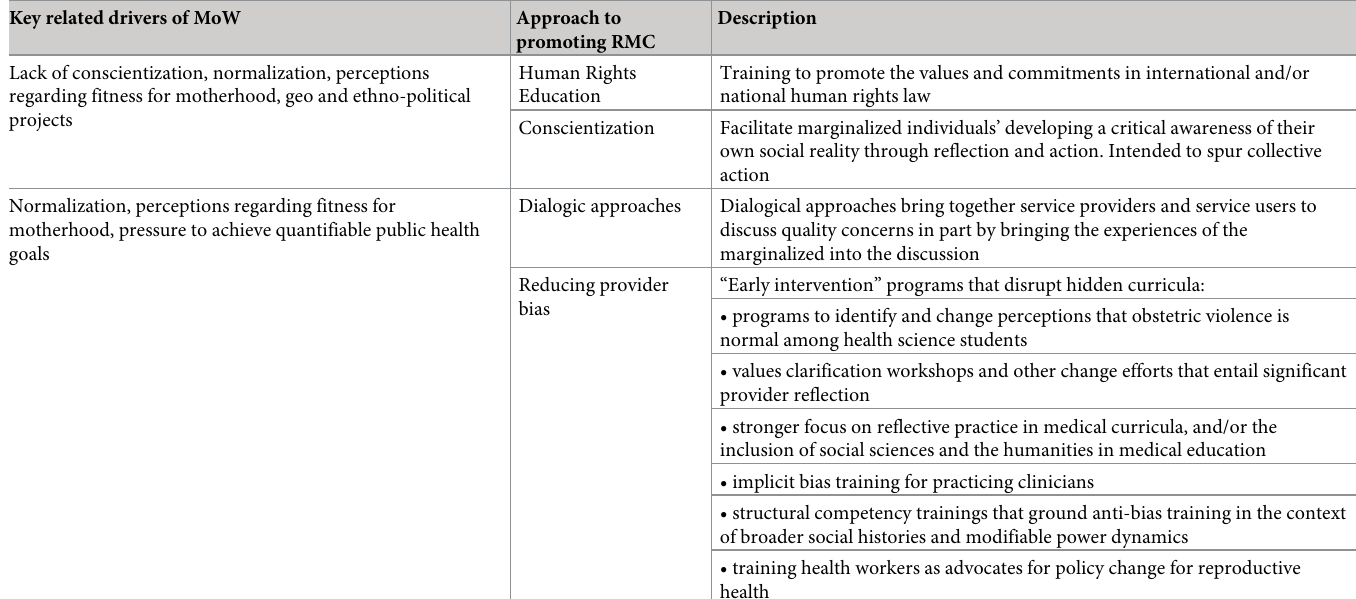
Table 2. Literature on ways that power dynamics could be shifted to promote RMC. Key related drivers of